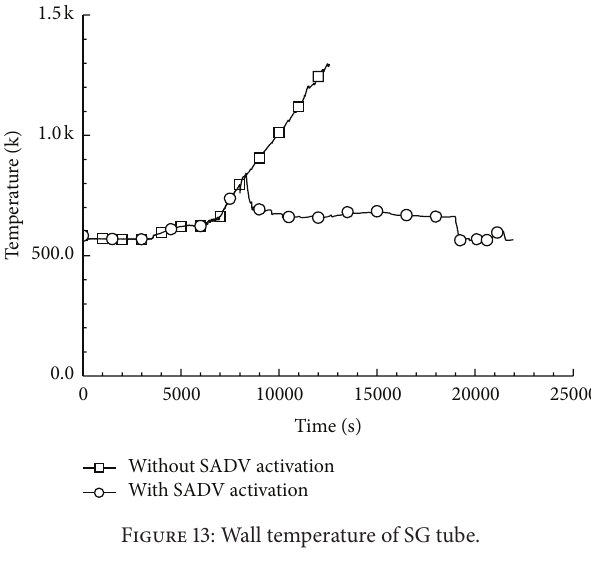
Figure 13: Wall temperature of SG tube.